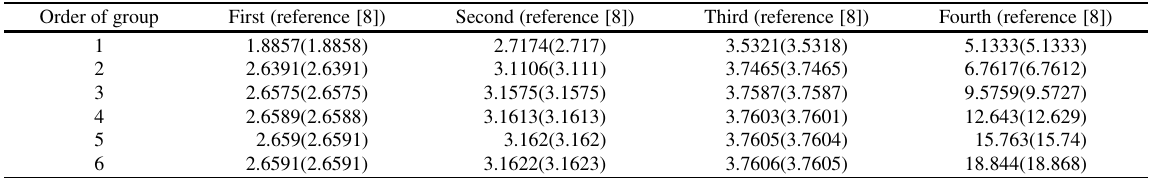
Table 3 The groups of dimensionless natural frequencies coefficients β i for a simply-simply supported beam with three segments of uniformly